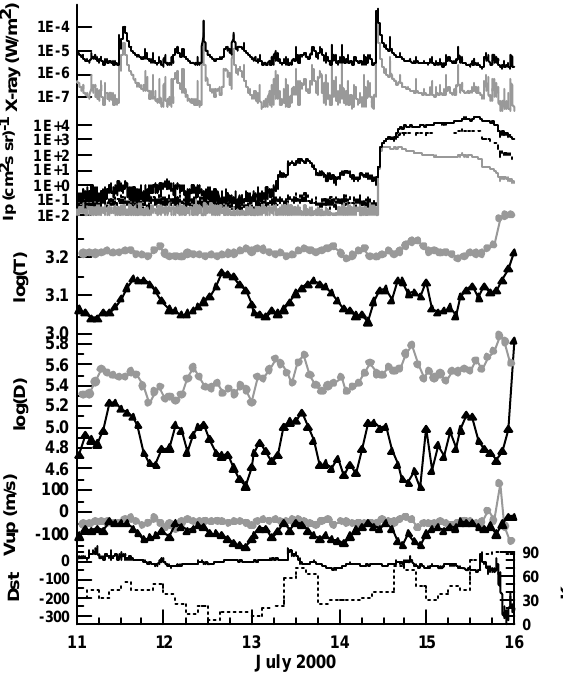
Fig. 1. Solar radiation, ionospheric and geomagnetic conditions Figure 2. The same as in Figure 1 but for the Halloween event on October 27-29, 2003. Fig. 2. The same as in Fig. 1 but for the Halloween event on Figure 1. Solar radiation, ionospheric and geomagnetic conditions preceding the Bastille Day preceding the Bastille Day from 11 to 15 July 2000 (from top to 27–29 October bottom): solar X-ray fluxes with wavelength 0.5–4 ˚A (gray line) from 11 to 15 July, 2000 (from top to bottom): solar X-ray fluxes with wavelength 0.5-4 Å and 1–8 ˚A (black line); integral fluxes of the interplanetary protons with energies > 5MeV (black line), > 30MeV (dashed line) and (gray line) and 1-8 Å (black line); integral fluxes of the interplanetary protons with energies > 100MeV (gray line); average temperature (K), density (cm − 3 ) , and vertical ion drift velocity measured in the top-side ionosphere >5 MeV (black line), >30 MeV (dashed line) and >100 MeV (gray line); average temperature by the ROCSAT-1/ IPEI during sunlit (gray circles) and night- side passes (black triangles); geomagnetic indices Kp (dashed his- (K), density (cm -3 ), and vertical ion drift velocity measured in the top-side ionosphere by the togram, right axis) and 1-min Dst (solid line). ROCSAT-1/ IPEI during sunlit (gray circles) and nightside passes (black triangles); geomagnetic indices Kp (dashed histogram, right axis) and 1-min Dst (solid line).